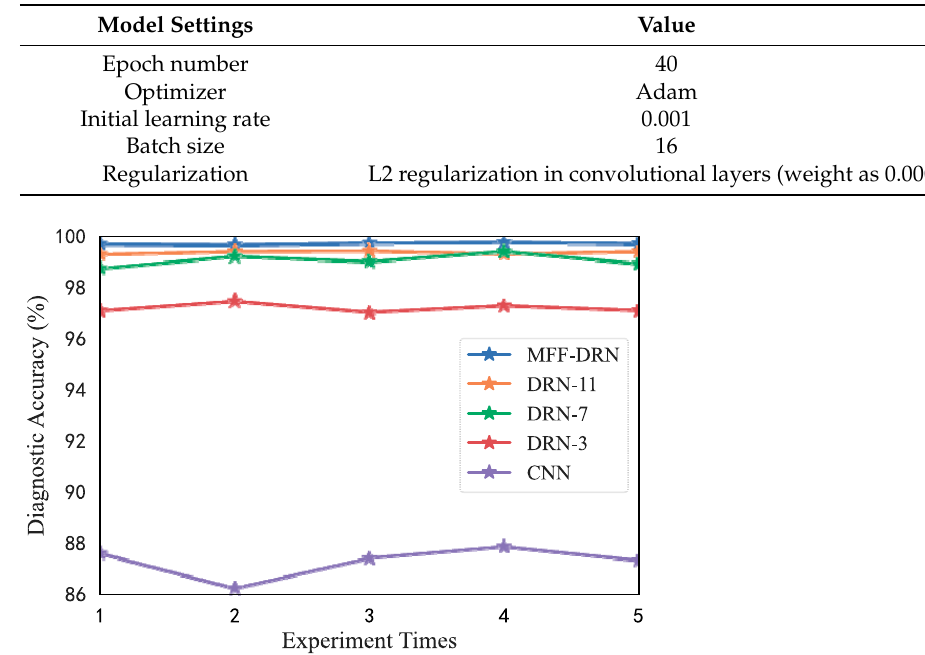
Table 3. The training settings for all models.